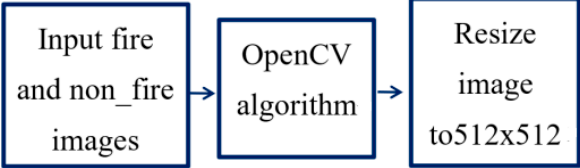
Figure 4. The overall process of resizing images.